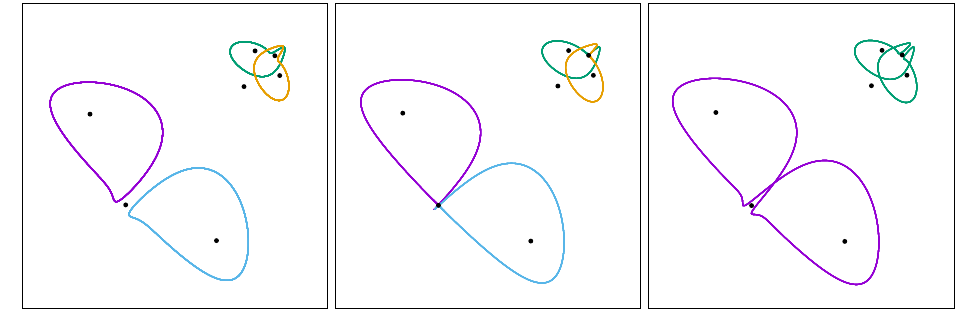
Figure 5. Collision of two pairs of periodic orbits with an equilibrium ( middle ); the equilibria are marked by a bullet. Before the collision ( left ), four periodic stable periodic orbits coexist. After the collision ( right ), only two stable periodic orbits coexist. Hence, the collision of periodic orbits with an equilibrium reduces the number of coexisting attractors. All panels represent the square [ − 0.2,1 ] × [ − 0.2,1 ] in the ( x ) -plane. The used parameter values are: F = 0.6740 ( left ), F = 0.6740 0 , x 2 ( middle ), and F = 0.675184 ( right